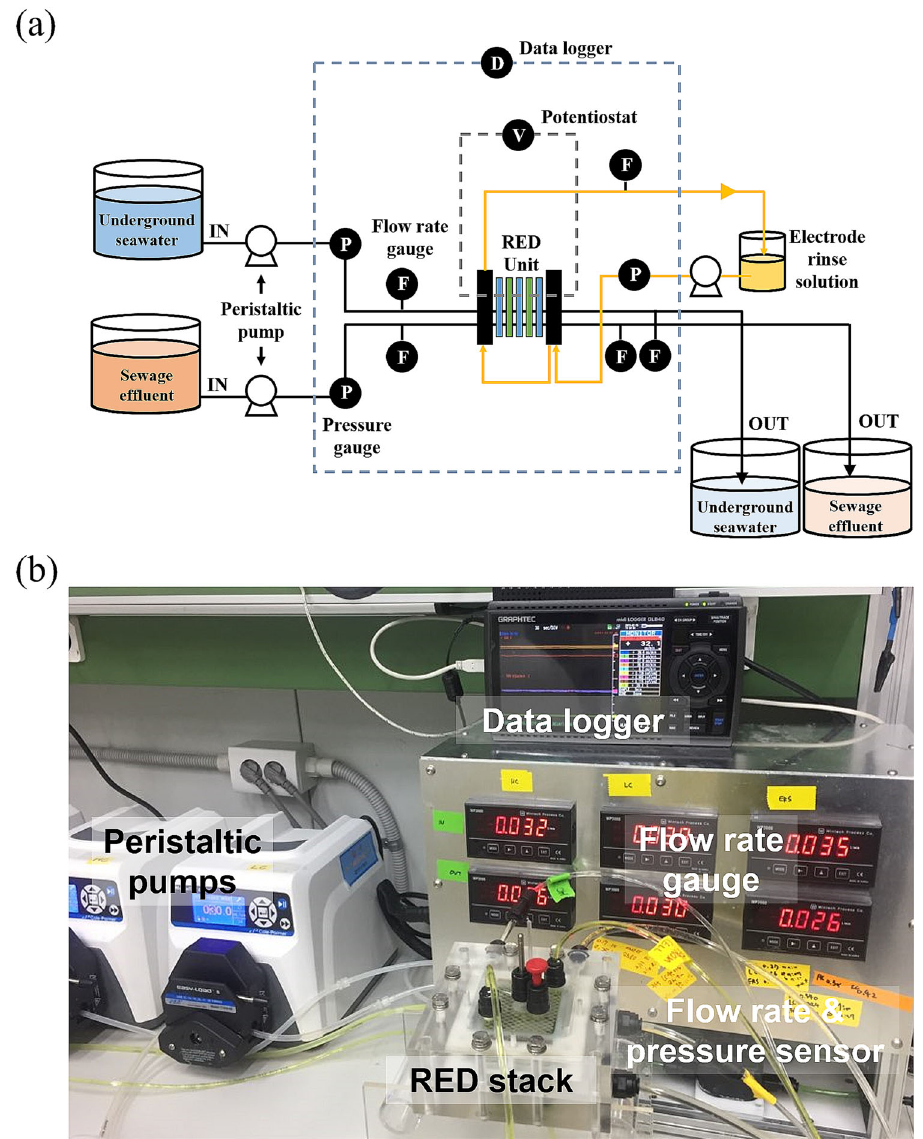
Fig. 8 Schematic representation of the experimental set-up and photographic image of the actual con fi guration for the RED process. a Shows simpli fi ed schematic representation of the experimental set-up. b Shows photographic image of the actual con fi guration for the RED